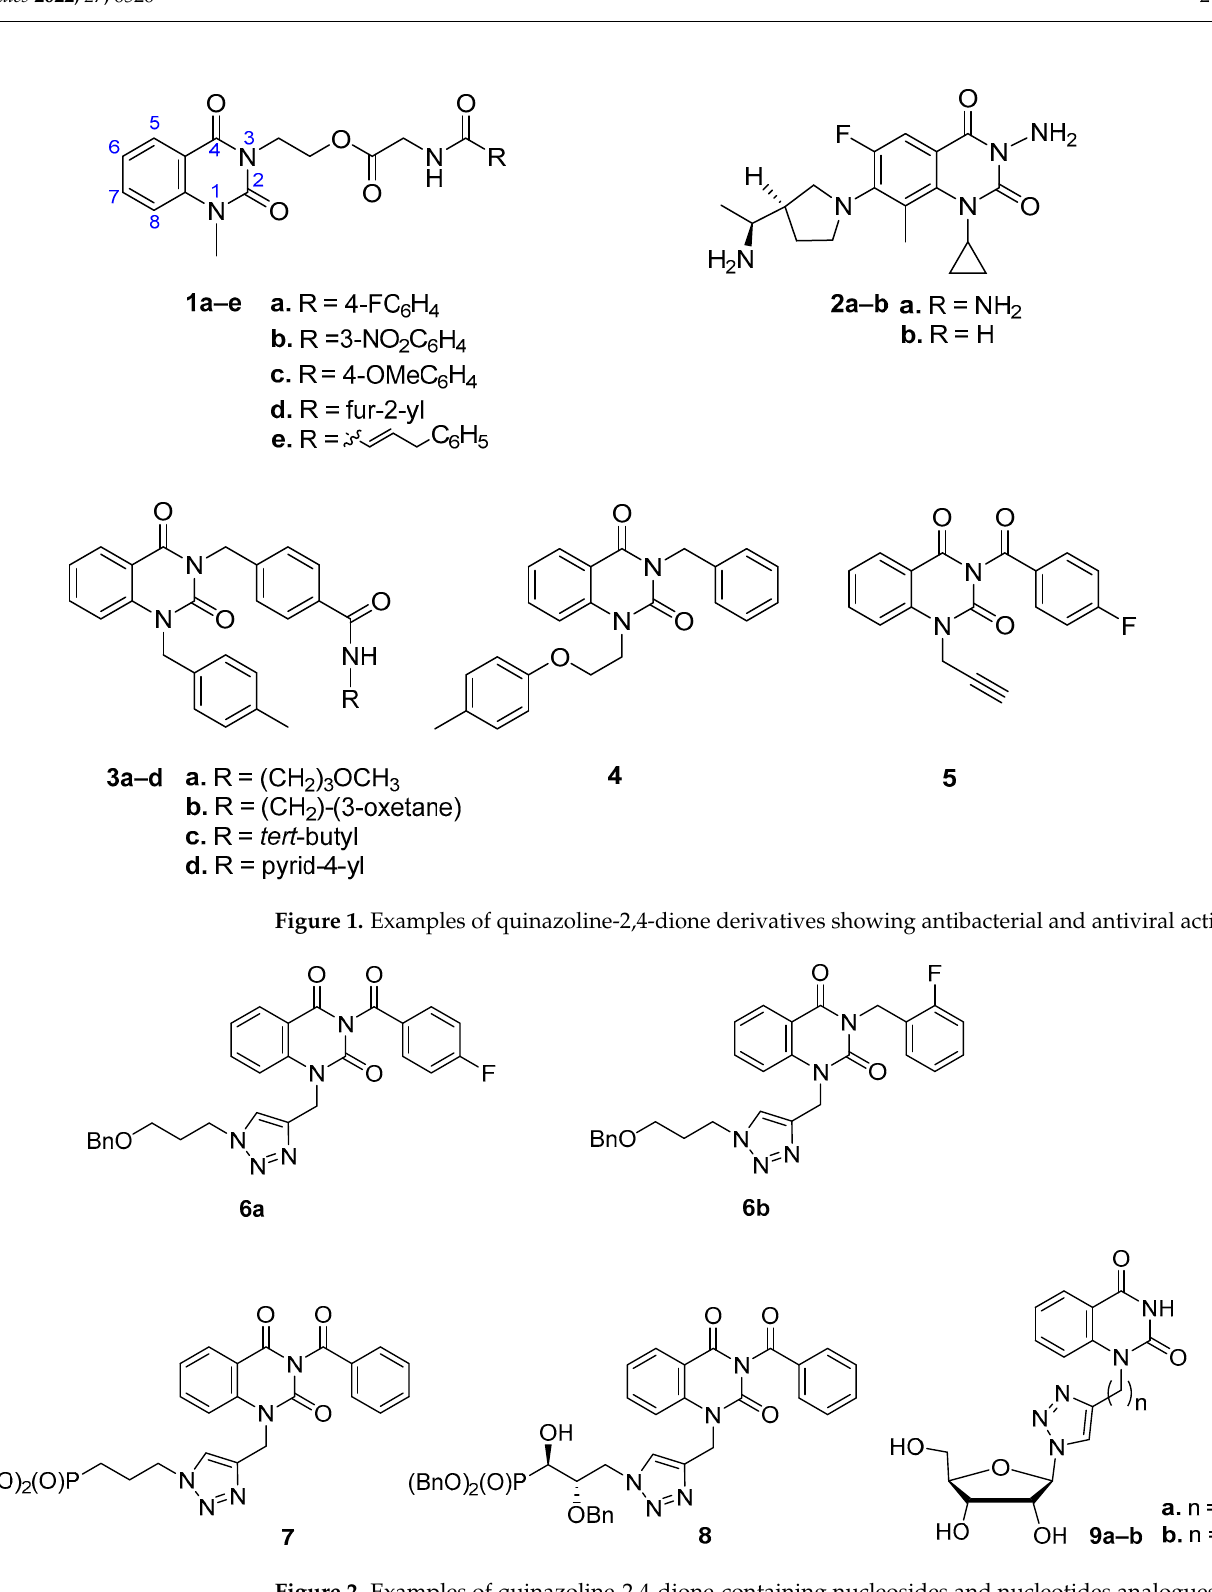
Figure 3. Examples of natural nucleosides (uridine, 2 ′ -deoxythymidine) and N3-substituted pyrim- idine nucleotide analogues 10-11 . Recently, we achieved the synthesis of isoxazolidine nucleotide analogues 12a–c with functionalized quinazoline-2,4-dione as a nucleobase replacer, and their promising anti- varicella-zoster virus (VZV) activity has been recognized (EC 50 = 3.0–5.1 µM) [18]. Based on the observed biological properties of various quinazoline-2,4-dione derivatives, such as 12, and in continuation of our studies on isoxazolidine analogues of nucleosides, a new series of compounds of the general formula 13 with quinazoline-2,4-dione linked via the N3 atom to the isoxazolidine moiety was synthesized to evaluate the biological activity. The route to construct the designed compound 13 relies on the 1,3-dipolar cycloaddition of N-substituted C -(diethoxyphosphonyl)nitrones 14–15 [19] with selected N3-allylated quinazoline-2,4-dione 16 functionalized at N3 with the respective benzyl group (Scheme 1).